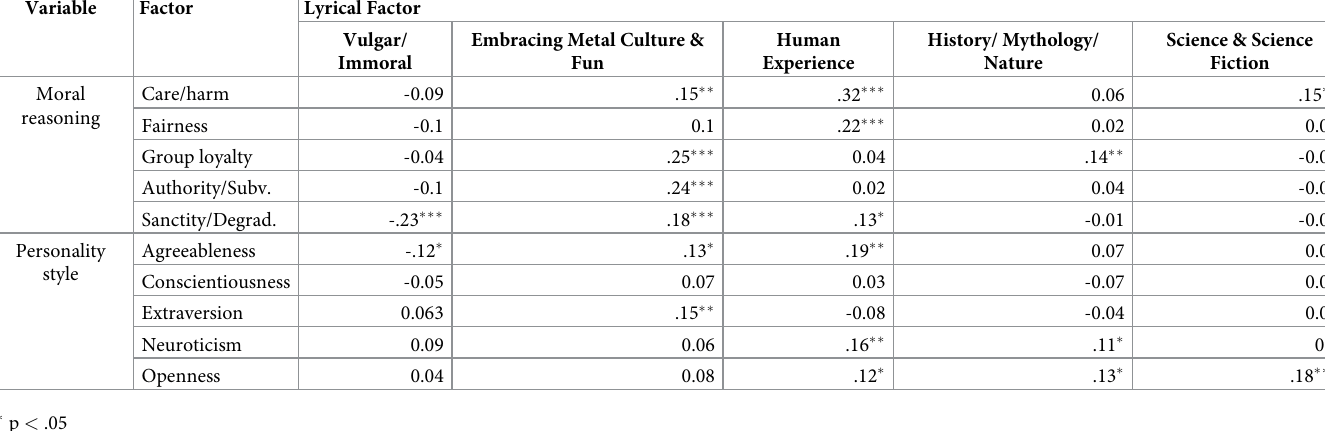
Table 5. Correlations between lyrical preferences with moral reasoning and personality